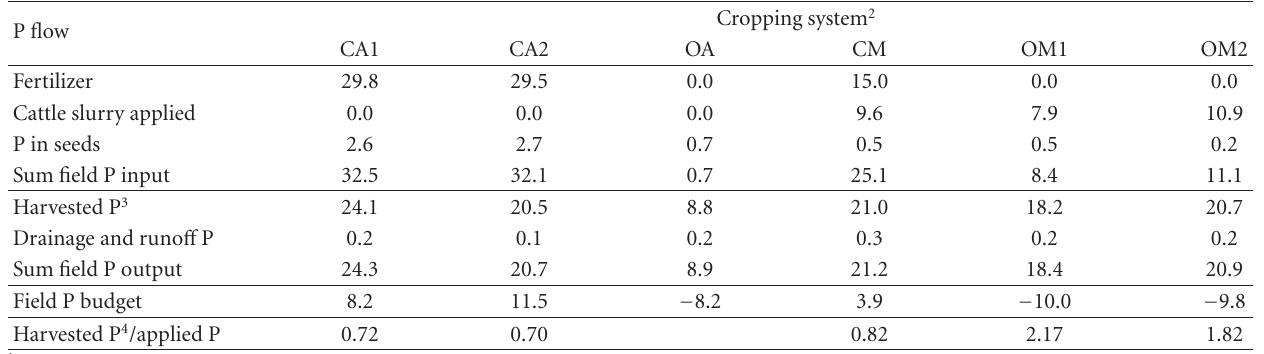
Table 6: Measured and estimated phosphorus flows (kg Pha − 1 year − 1 ) and selected quotients (kgPkg P − 1 ) in the cropping systems at Apelsvoll, mean 2001–2010 1